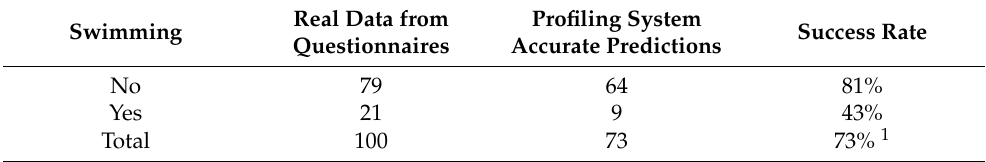
Table 10. Swimming activity. Swimming